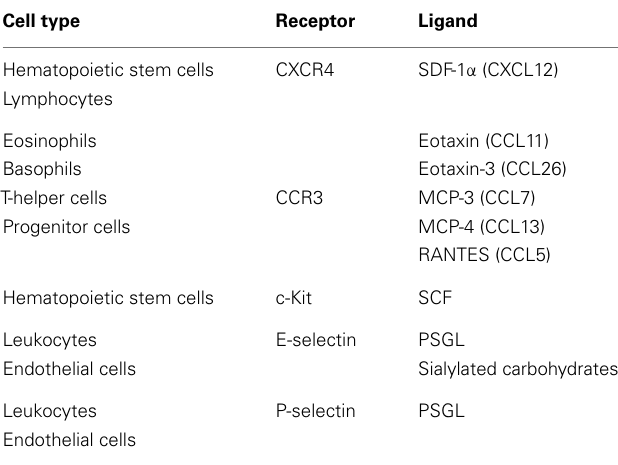
Table 2 | List of cell types and the presence of receptors and their ligands